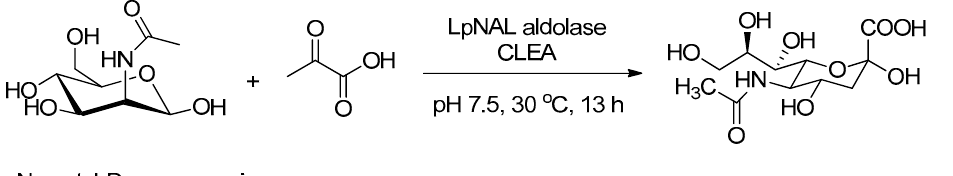
Figure 5. N -acetyl- D -neuraminic acid synthesis using a L. planatarum N -acetyl- D -neuraminic acid aldolase (NAL)-CLEA.